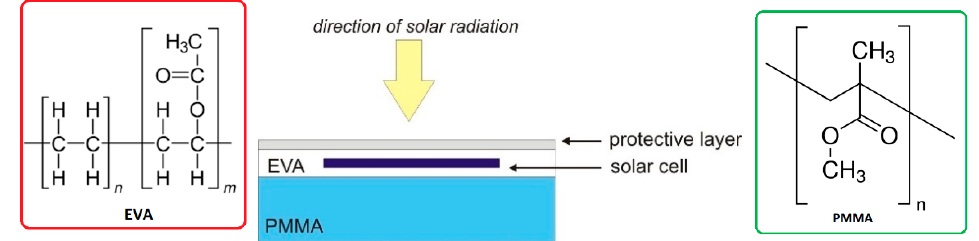
Figure 2. Schematic cross-section of the mini PV module along with chemical structure of poly(methyl methacrylate) (PMMA) and ethylene-vinyl acetate (EVA).